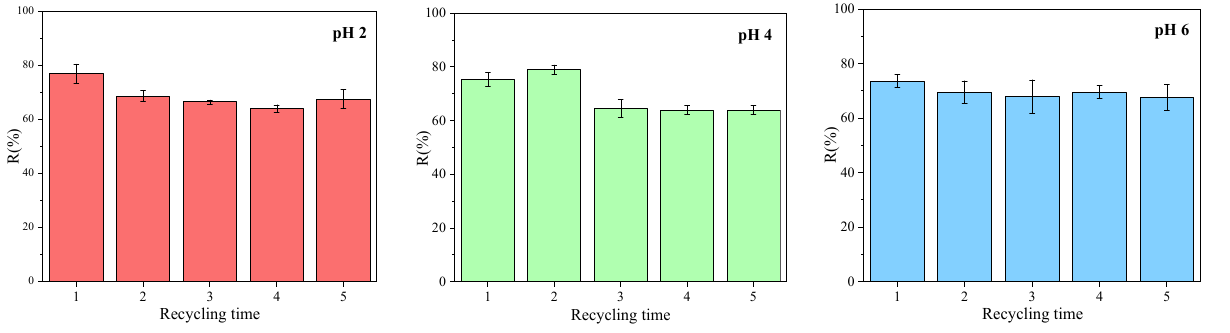
Figure 7. Re-adsorption efficiency of CHg-TA at different pH levels.